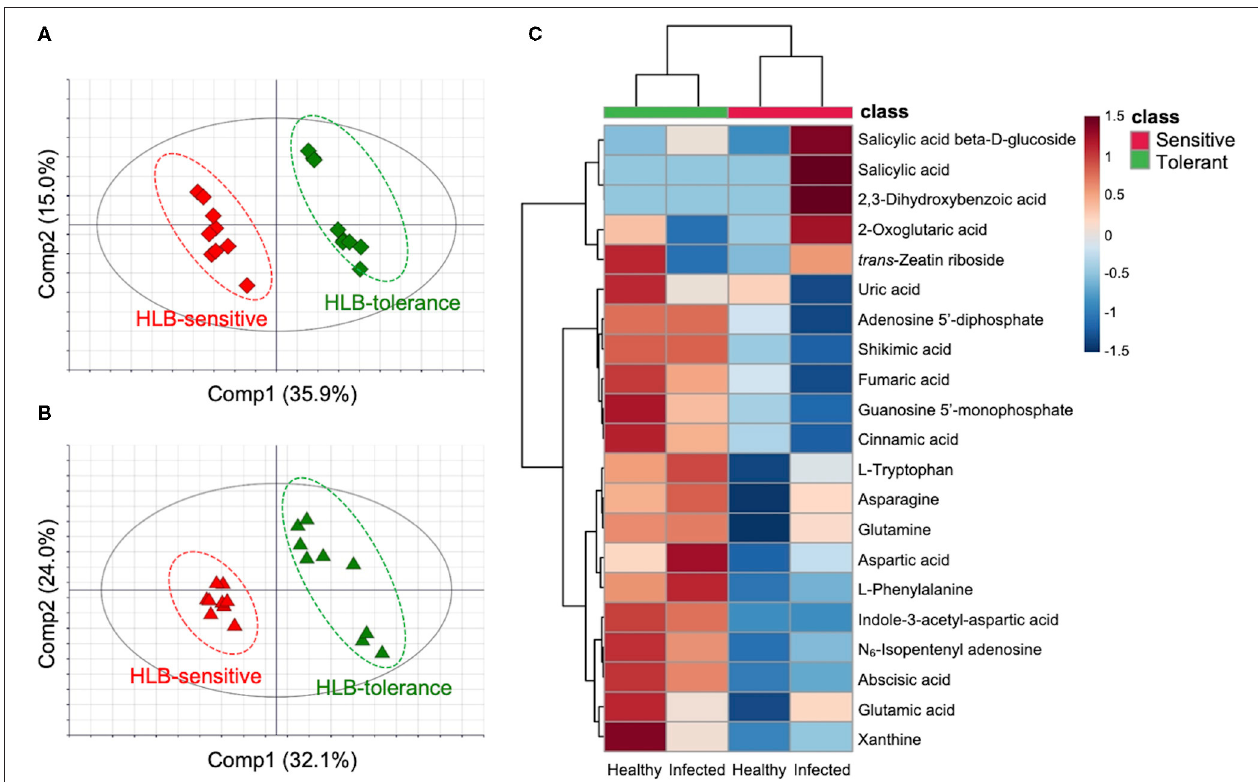
FIGURE 1 | Metabolic differences between Huanglongbing (HLB)-tolerant (Sugar Belle ® ) and HLB-sensitive (‘Murcott’) citrus cultivars ( n = 9). Partial least squares discriminant analysis score scatter plots of (A) healthy and (B) infected groups including HLB-tolerant samples (green) and HLB-sensitive samples (red). (C) Hierarchical clustering heat map of metabolites in four groups (healthy and infected HLB-tolerant and HLB-sensitive samples). All visualized metabolites are marker compounds [Variable importance in projection (VIP) score > 1.0, p -value < 0.05, and |fold change| > 1.5] involved in the pivotal pathways biosynthesis of plant hormones (BPH), aspartate and glutamate metabolism (AGM), and purine metabolism (PM)] related to HLB tolerance. The color depth of the heat map represents the degree of metabolic responses as follows: red color denotes increased responses and blue color denotes decreased